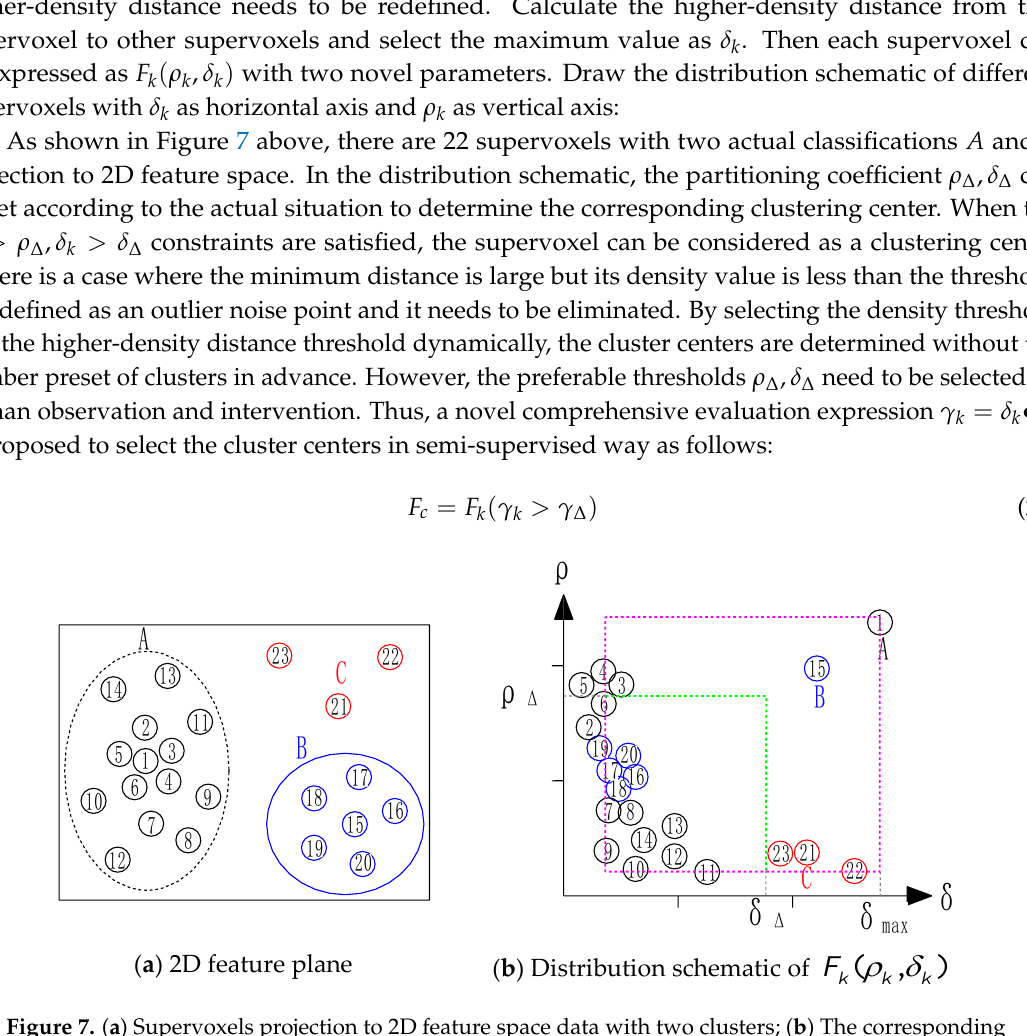
Figure 7. ( a ) Supervoxels projection to 2D feature space data with two clusters; ( b ) The corresponding distribution schematic with F k ( ρ k , δ k )